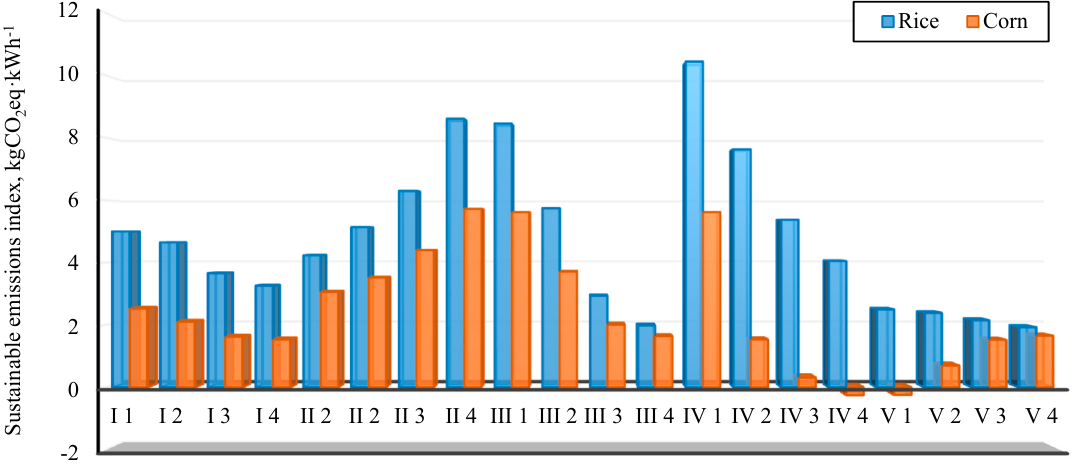
Figure 5. Results of the sustainable CO 2 emissions index for each disc speed configuration.